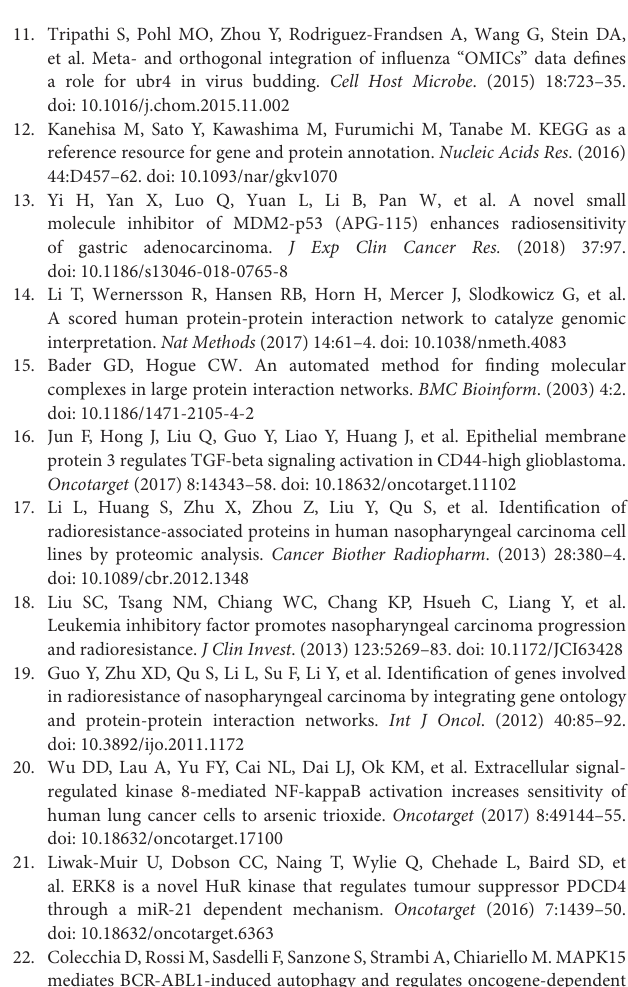
Table S1 | Quantitative proteomic analysis using TMT labeling and LC-MS/MS analysis. In total, 5,946 protein groups were identified, among which 5,185 proteins were quantified. Table S2 | Radiosensitivity-related proteins identified in previous 2-DE/ MALDI-TOF-MS studies and in our study. Table S3 | Intensive bioinformatic analysis identified 754 differentially expressed proteins with fold change ≥